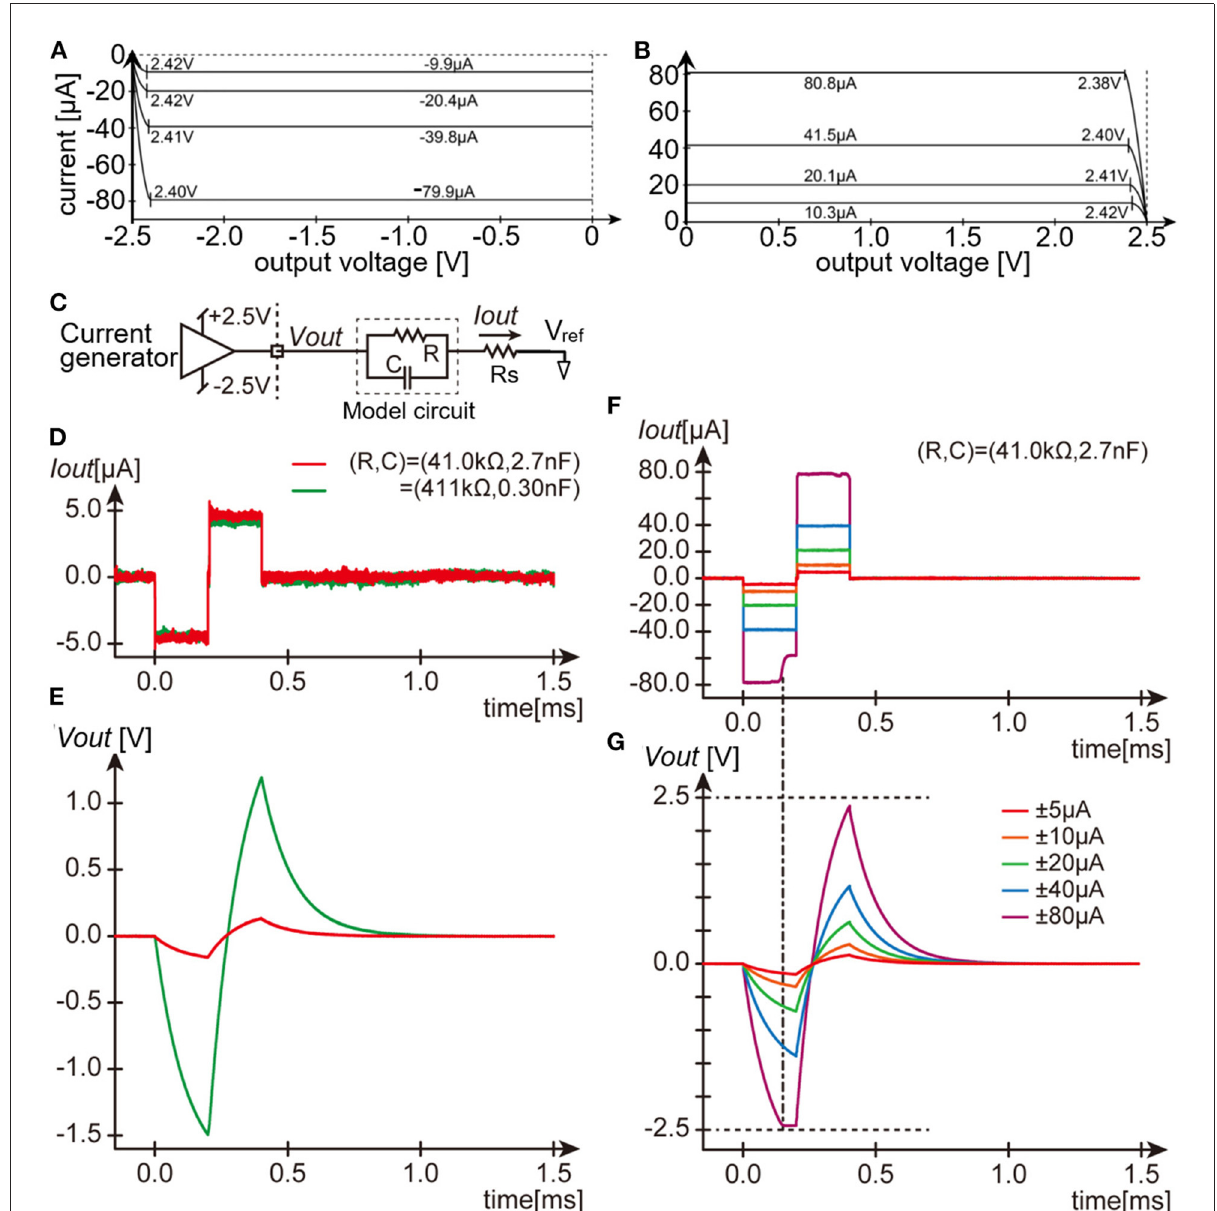
FIGURE2 Dry-bench tests of the stimulation module. (A,B) Measurements of the output DC impedance of the current generator for the negative current (A) and positive current (B) . (C) Schematic circuit diagram testing the current pulse output. (D,E) Recorded traces of the output current pulses (D) and the resulting output voltage (E) with the same amplitude setting but with two different parameters of the model circuit. (F,G) Recorded traces of the output current pulses (F) and the resulting output voltage (G) with different amplitude settings and with the same model circuit parameters. Note the voltage drop across Rs ( ∼ 80mV in the largest case) is hardly visible in the traces in (E , G) .